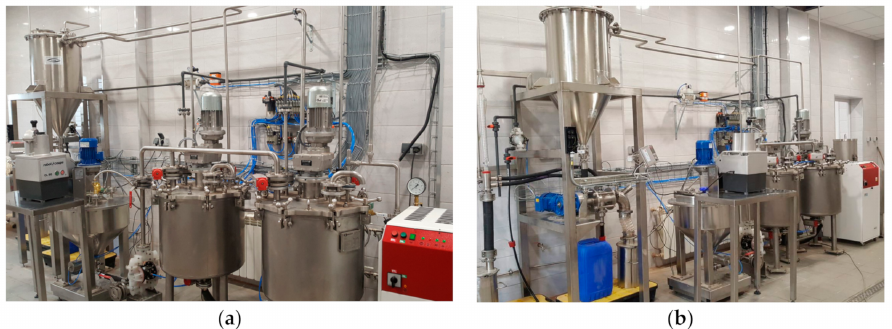
Figure 4. Photographs of an installation located in the sugar factory at Dobrzelin for processing beet pulp and beet leaves into furfural on a quarter-technical scale ( a ) right side view ( b ) left side view. Table 2. Influence of changes in furfural production volume on the value of discounted cash flows over a 10-year period.